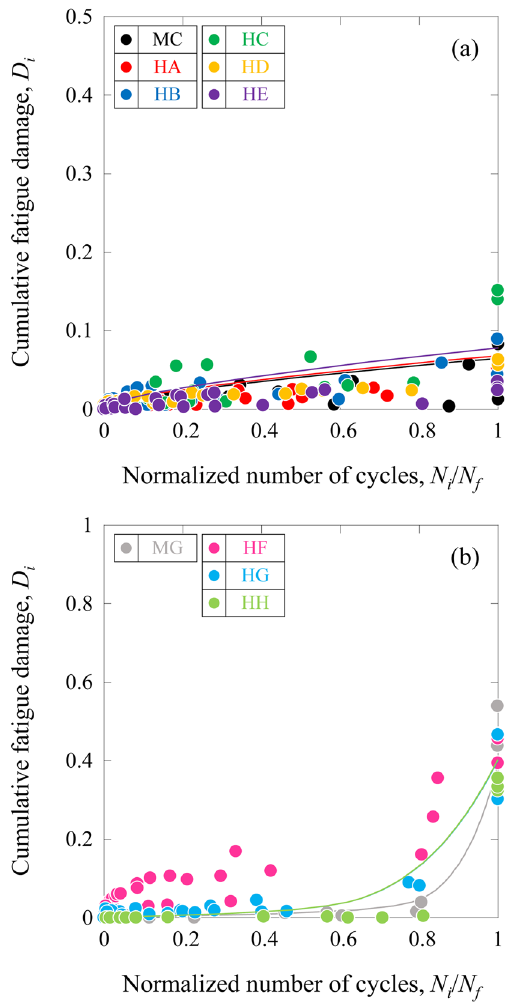
Figure 9. Cumulative fatigue damage for the CFRP, GFRP, and HFRP specimens as a function of the normalized number of cycles. ( a ) HA ([(0 (IMS60) )/(0 (E-glass) )] S ), HB ([(0 (E-glass) )/(0 (IMS60) )] S ), HC ([(0 (E-glass)